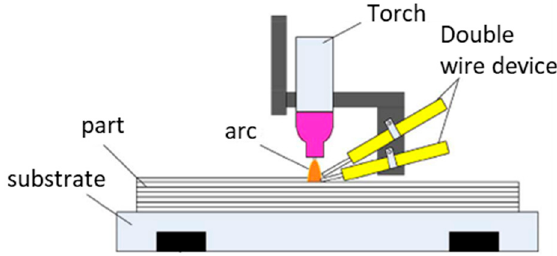
Figure 18. Schematic representation of double wire setup (adapted from [93]).